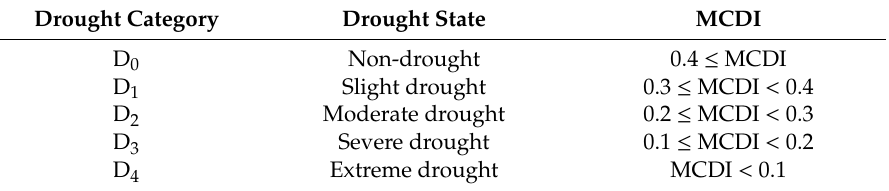
Table 1. Drought Intensity Classification based on CDI